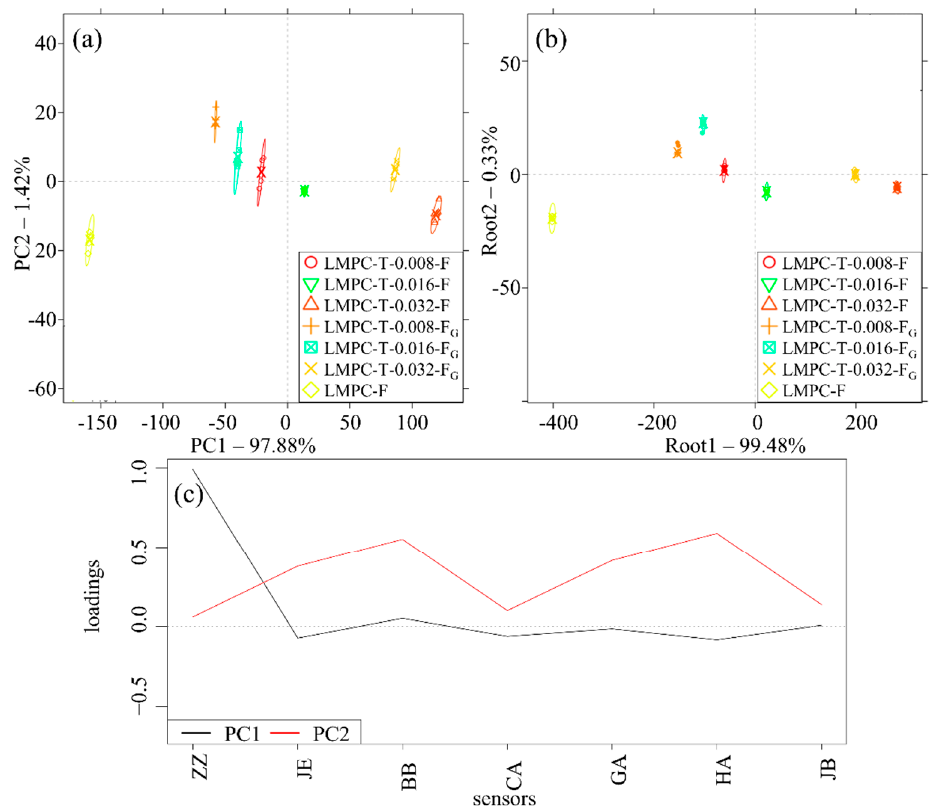
Figure 3. PCA score plot ( a ), LDA score plot ( b ) and PCA loading plots ( c ), which were developed based on the results of the E-tongue with aqueous solutions of LMPC-T-0.008-F, LMPC-T-0.016-F, LMPC-T-0.032-F, LMPC-T-0.008-F G , LMPC-T-0.016-F G , LMPC-T-0.032-F G and LMPC (ellipses show the 95% confidence intervals, filled dots on the LDA figure represent the observations used in the cross-validation). LMPC: liquid milk protein concentrate, T: trypsin, F: fermentation with lactic acid bacteria in the absence of glucose, F G : fermentation with lactic acid bacteria in the presence of glucose.